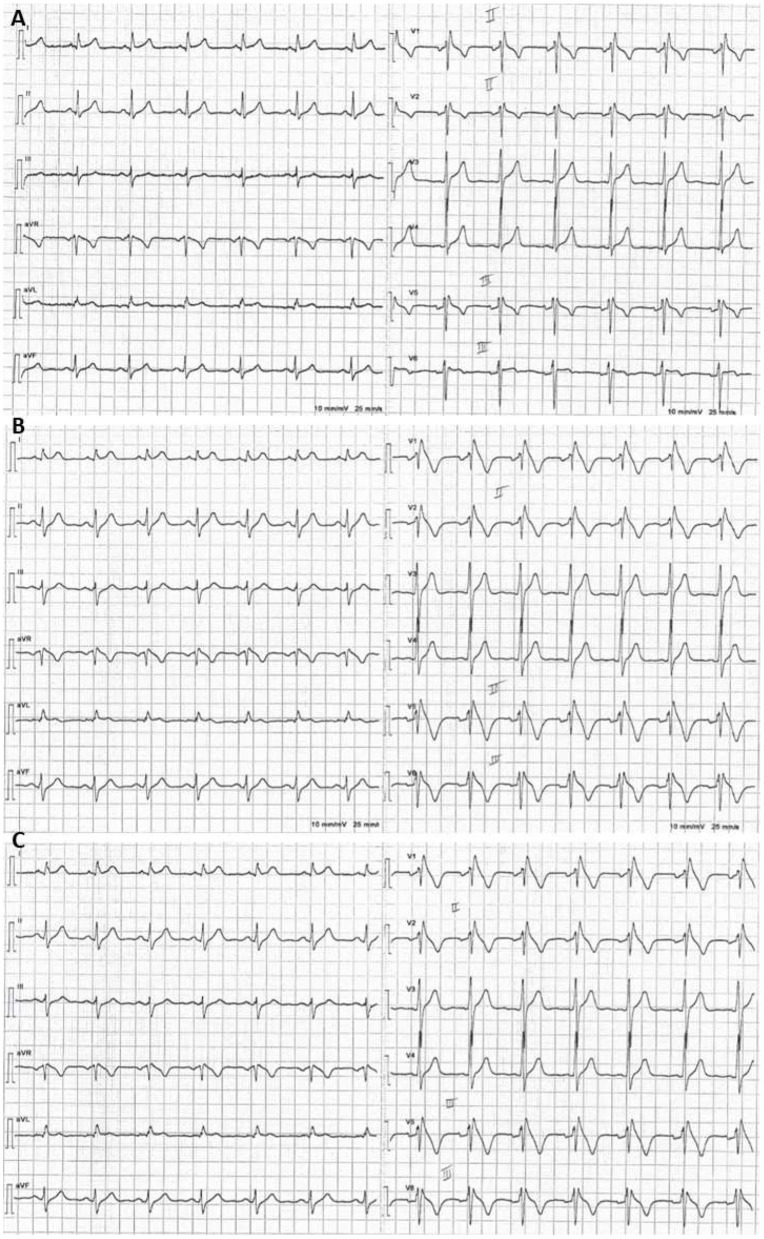
Example of a positive ajmaline test: basal ECG with V1–V2 in the 2nd intercostal space showing minimal r′. (A) Five minutes after starting intravenous infusion of ajmaline, a type 1 BrS ECG pattern emerged (B) and persisted over the following minute (C).